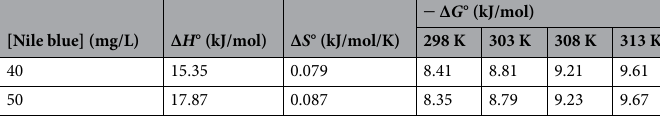
Table 6. Thermodynamic parameters.